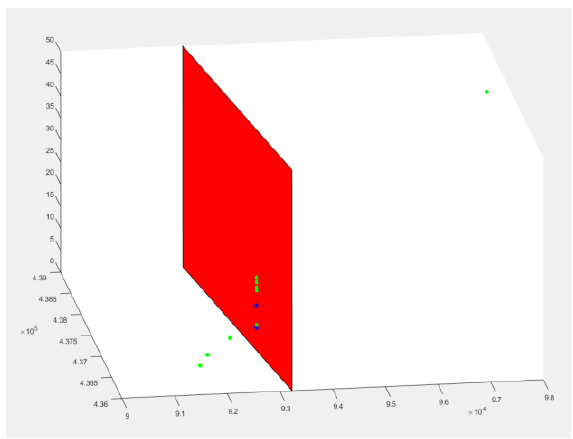
Figure 14. Plane fitting in a sparse point cloud with outliers. Please note: the triangulation of mismatches scaled the scene accordingly. The blue points depicting the MM recording locations are not on the plane.